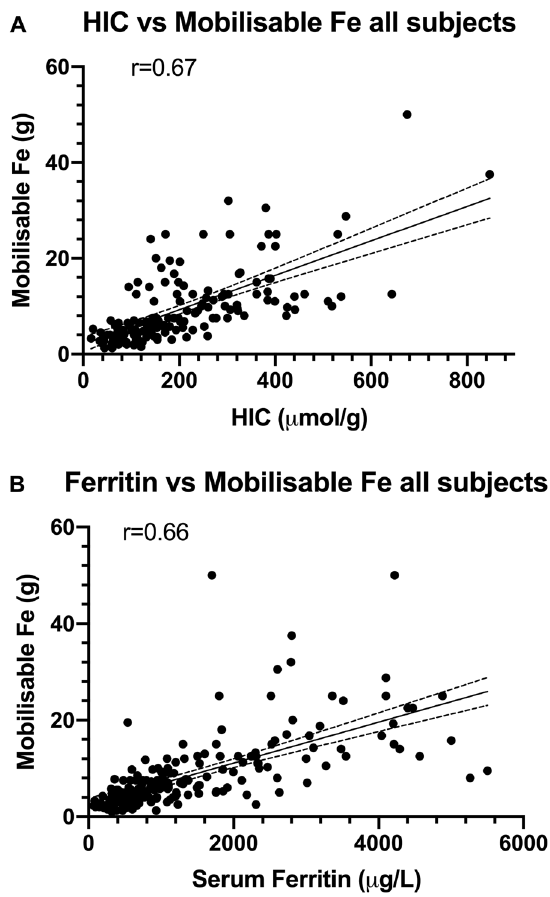
Figure 2. Correlation between ( A ) HIC and mobilisable and ( B ) serum ferritin level and mobilisable iron. The 95% confidence intervals are shown on the graphs as dotted lines.